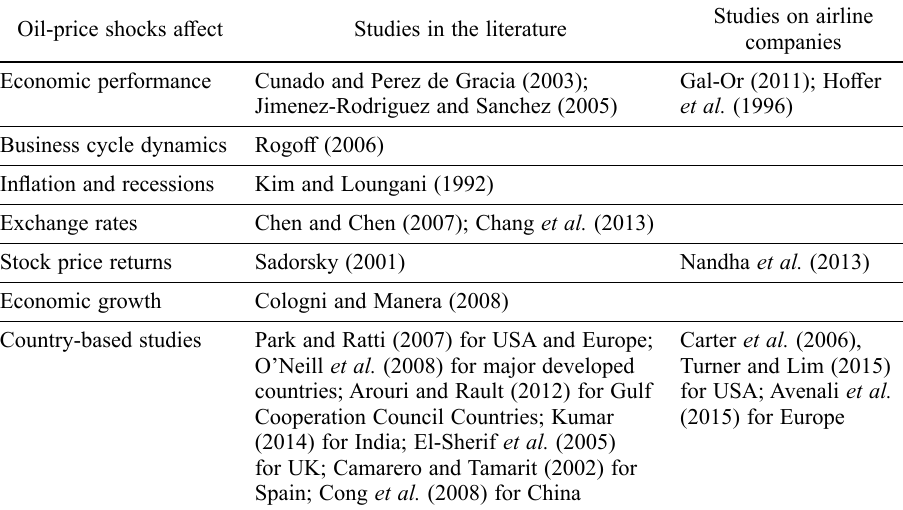
Fig. 1. Crude oil price dynamics Source : Table 1. Relationships between oil-price variations, financial and economic variables